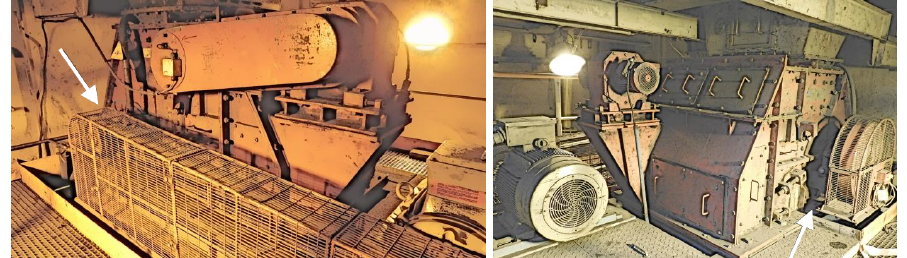
Figure 4. Photography of both sides of the monitored crusher—the approximate location of the sensors is indicated by